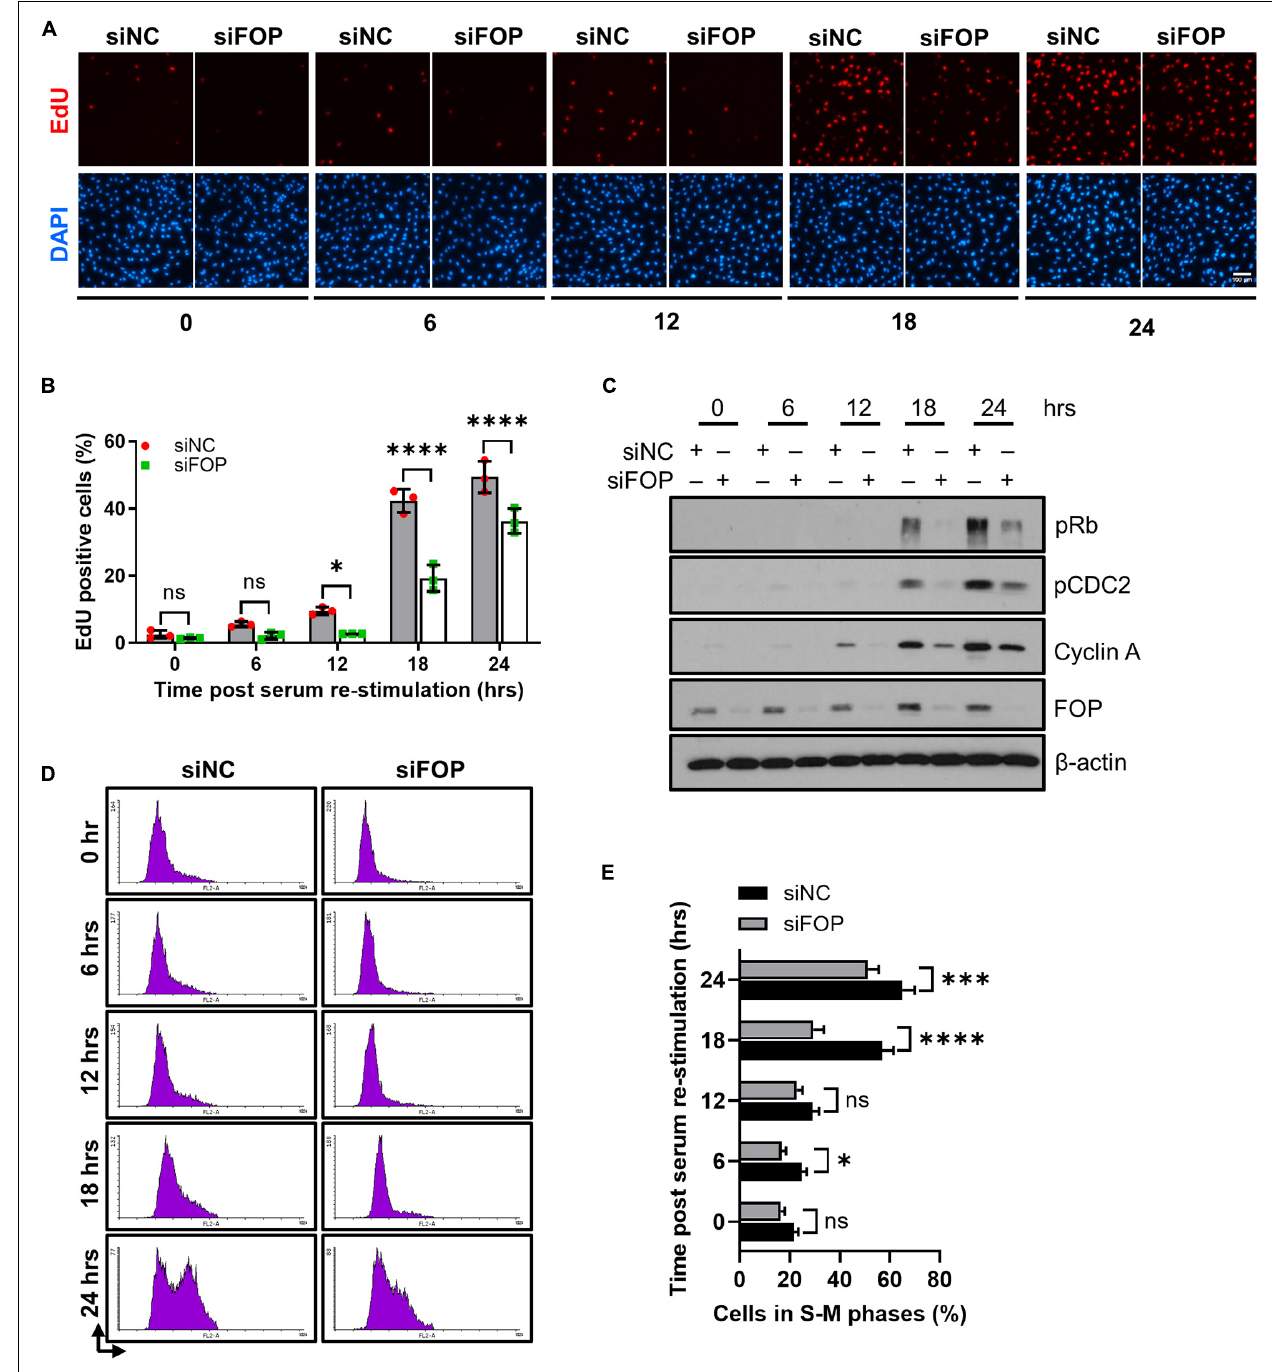
FIGURE 5 | Knockdown of FOP delays cell cycle re-entry. (A) RPE1 cells were transfected with siNC or FOP siRNAs followed by 48 h of serum-starvation. Cells were then serum re-stimulated for the indicated durations, with cells being labeled with EdU during the final 2 h before cell harvesting. The nuclei were stained with DAPI. Scale bar, 100 µ m. (B) Quantification of the percentage of EdU positive cells described in (A) . At least 500 cells per sample were analyzed in each experiment. (C) Immunoblotting analysis of the phosphorylation levels of Rb at Ser807/811 (pRb) and CDC2 at Tyr 15 (pCDC2) and the levels of Cyclin A and FOP in siNC and siFOP cells at 0, 6, 12, 18, and 24 h post serum re-stimulation. (D) Cell cycle profiles of siNC and siFOP treated cells at 0, 6, 12, 18, and 24 h after serum re-stimulation were determined by flow cytometry. At least 10,000 cells per sample were analyzed in each experiment. (E) Quantification of the percentage of S-M phases cells described in (D) . Data are presented as mean ± SD from three independent experiments; ns, not significant; * p < 0.05; *** p < 0.001; **** p < 0.0001(Two-way ANOVA followed by Tukey’s multiple comparisons test).